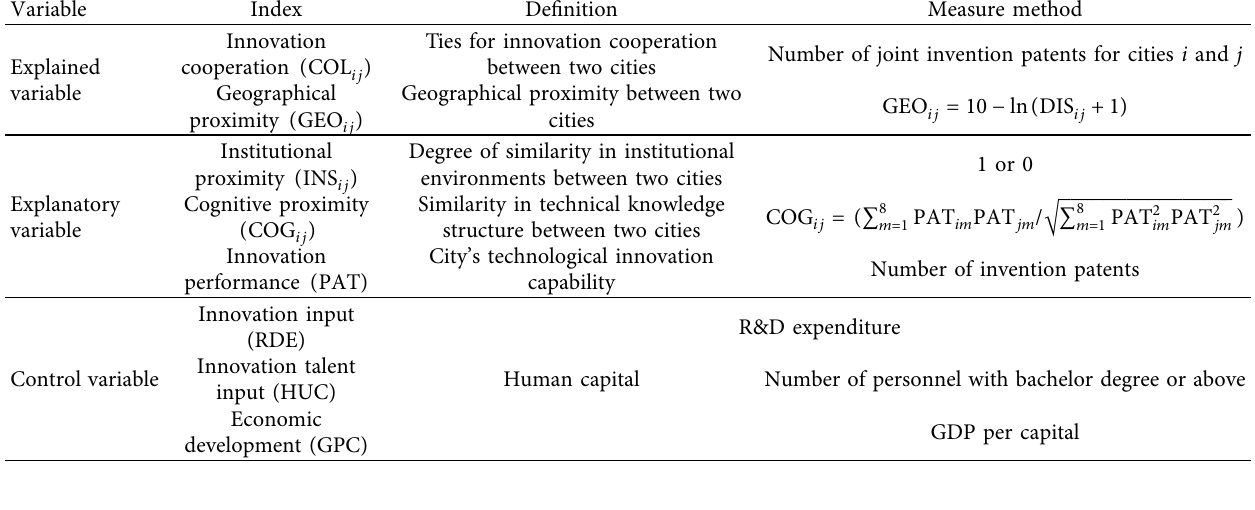
Table 1: Definitions of variables in the proximity mechanism model for intercity innovation networks.